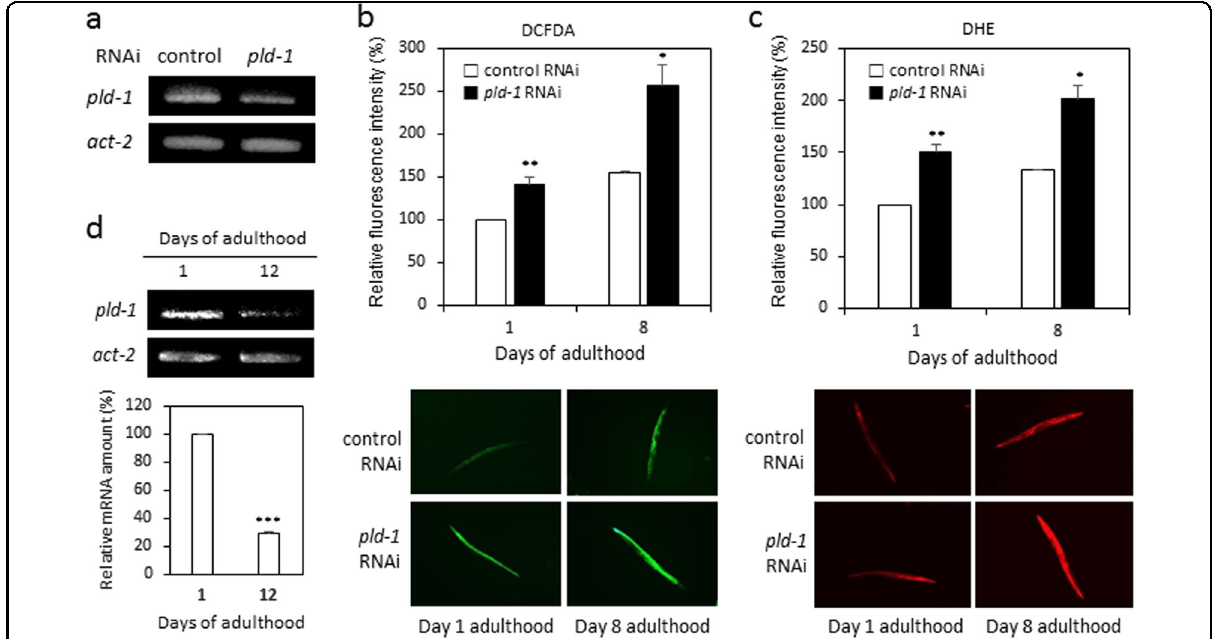
Fig. 1 Pld-1 RNAi promotes ROS formation in nematodes and pld-1 expression inversely correlates with aging. a Effect of pld-1 RNAi on pld-1 expression in nematodes. Lysates from nematodes at day 1 of adulthood fed with pld-1 RNAi or control RNAi were utilized in RT-PCR using speci fi c pld-1 primers. PCR products were resolved on a 1.5% agarose gel. Representative data from three independent experiments are shown. act-2 mRNA served as the loading control. Nematodes fed with pld-1 RNAi or control RNAi were incubated with DCFDA ( b ) or DHE ( c ). The fl uorescence intensity of nematodes at day 1 or 8 of adulthood (upper panels) was quanti fi ed using ImageJ software by determining the average pixel intensity ( n > 116 per day 1 condition; n > 73 per day 8 condition). Data are shown as the means ± SEM. * P < 0.05, ** P < 0.01. Representative images of nematodes were obtained at 10× magni fi cation (bottom panels). d Age-dependent reduction in pld-1 mRNA levels. Lysates from nematodes at days 1 and 12